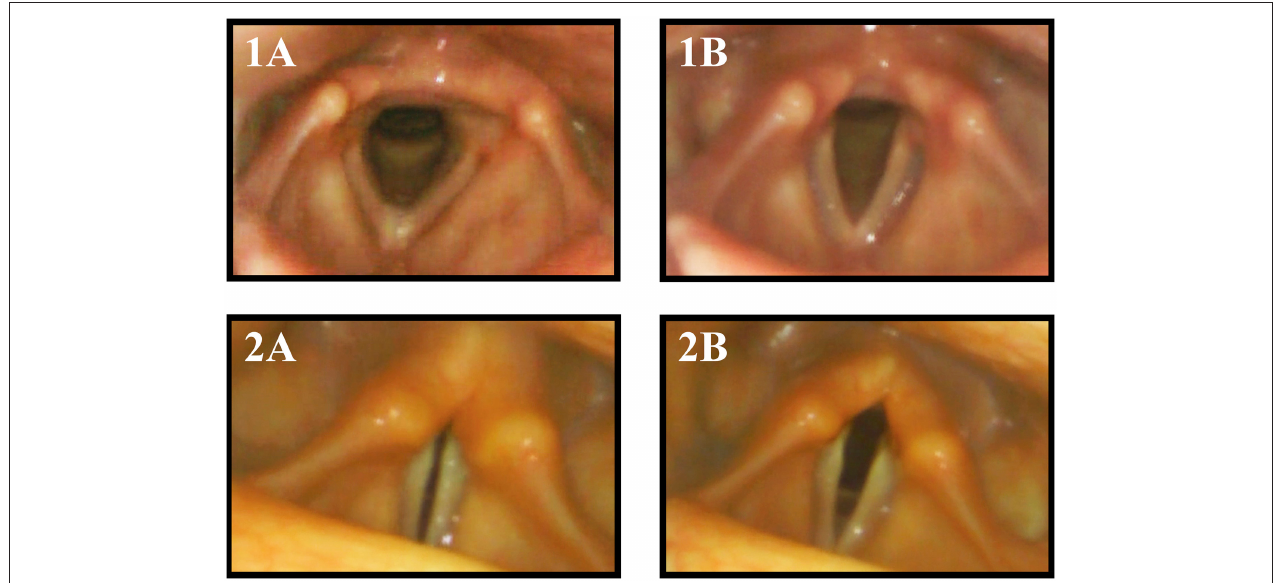
FIGURE 1 | Vocal fold motion during breathing with inspiration (A) and expiration (B) in a healthy control subject (1) and MSA patient (2). The MSA patient exhibited paradoxical vocal fold motion with inspiratory stridor.